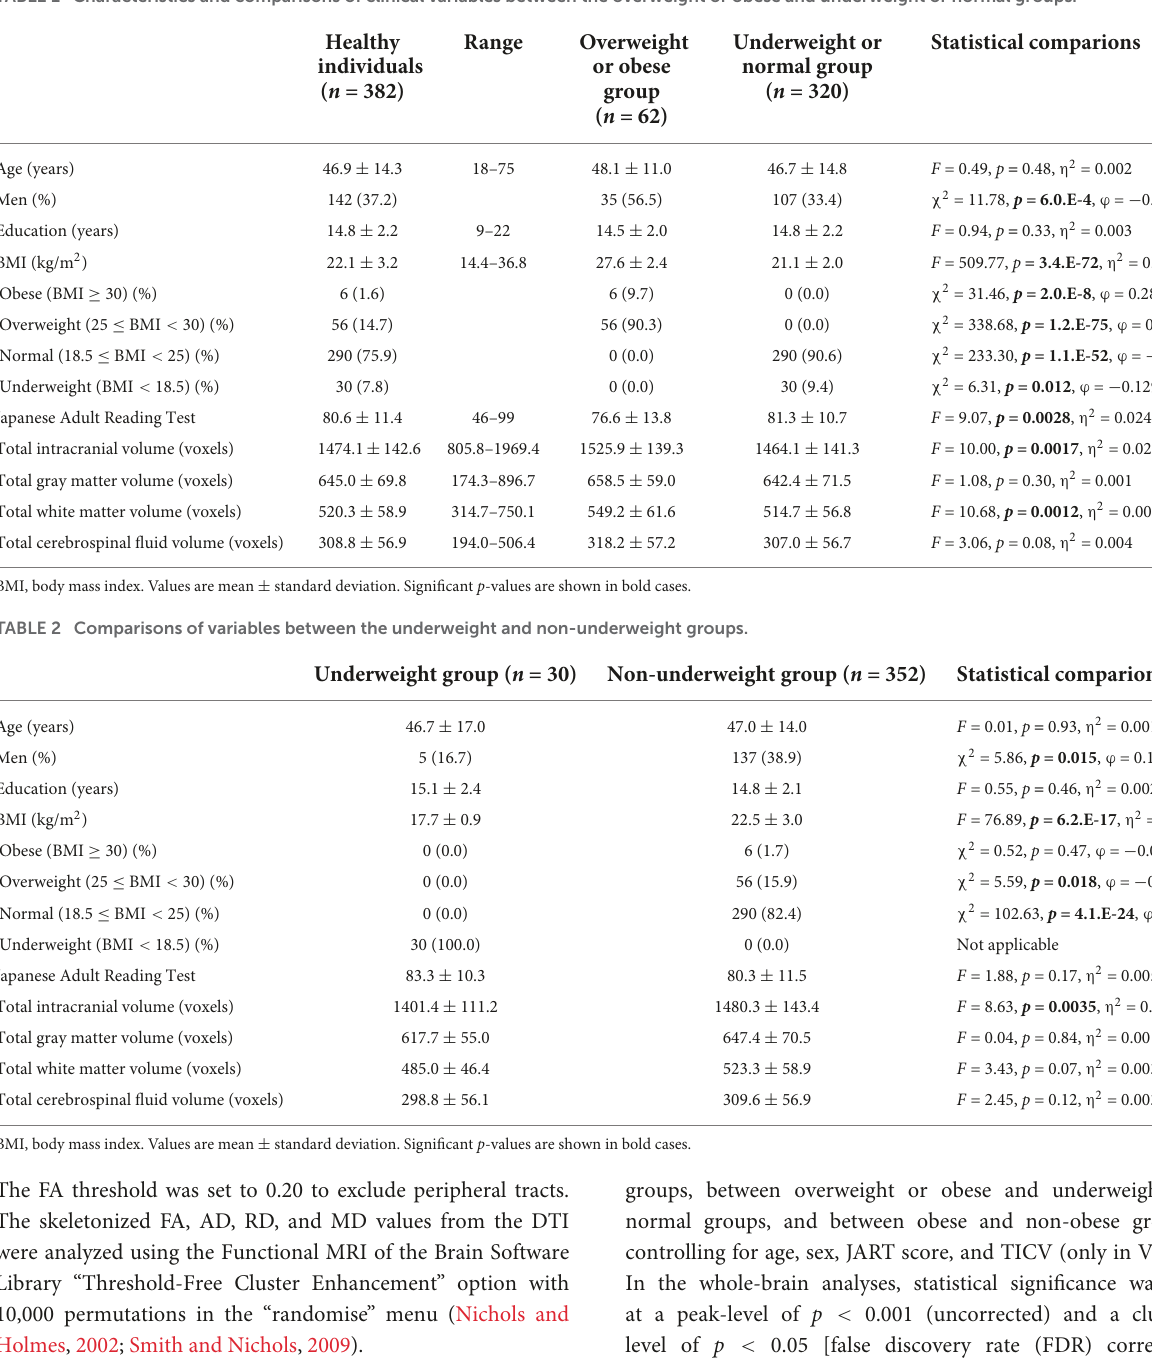
TABLE 1 Characteristics and comparisons of clinical variables between the overweight or obese and underweight or normal groups.